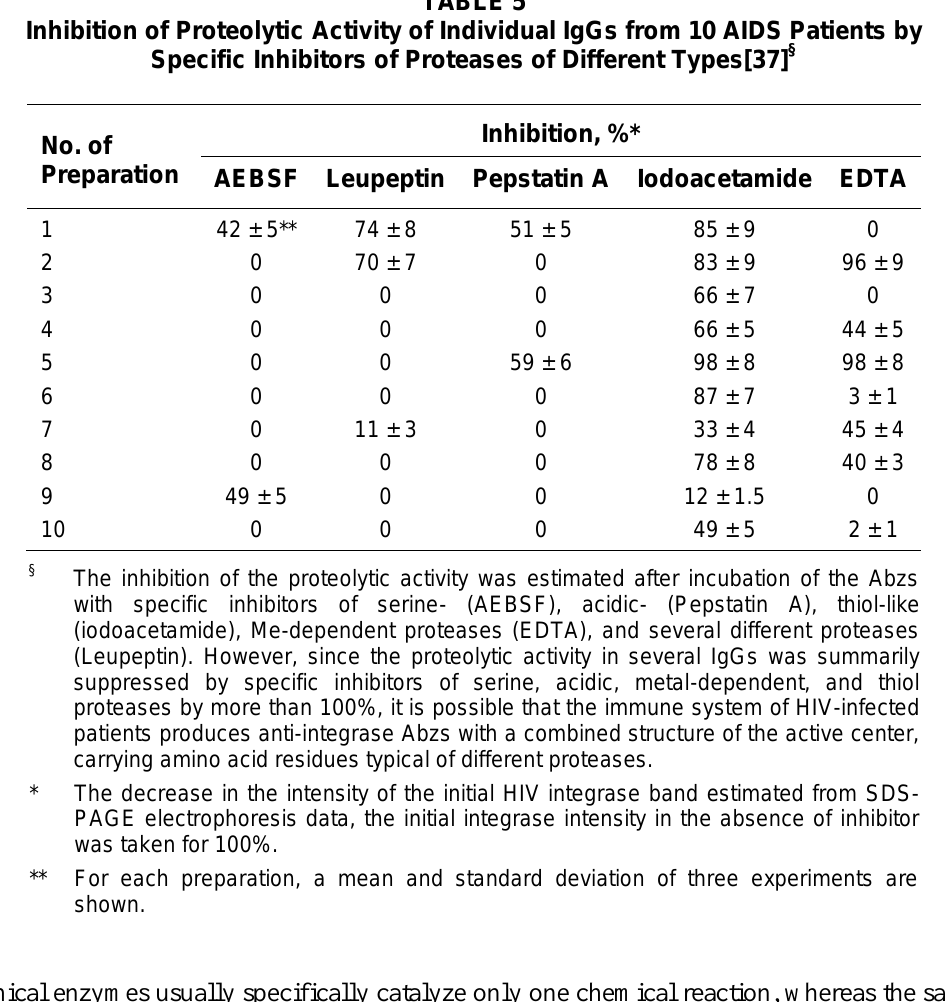
Inhibition of Proteolytic Activity of Individual IgGs from 10 AIDS Patients by Specific Inhibitors of Proteases of Different Types[37] §